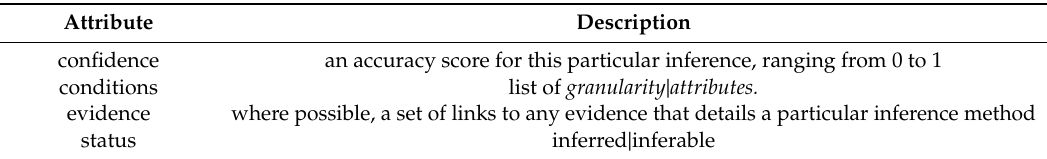
Table 3. Secondary data